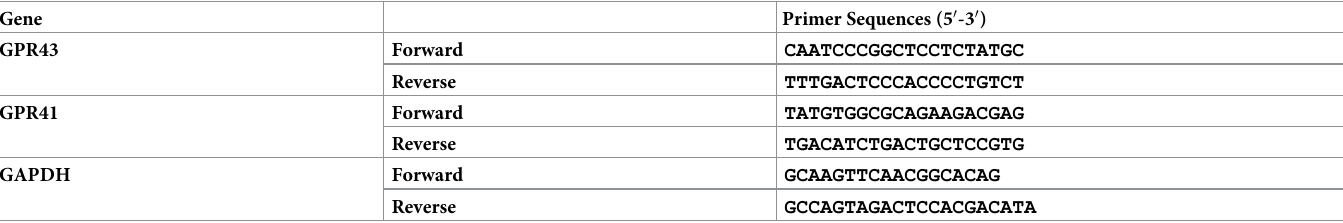
Table 1. Primer sequences used for